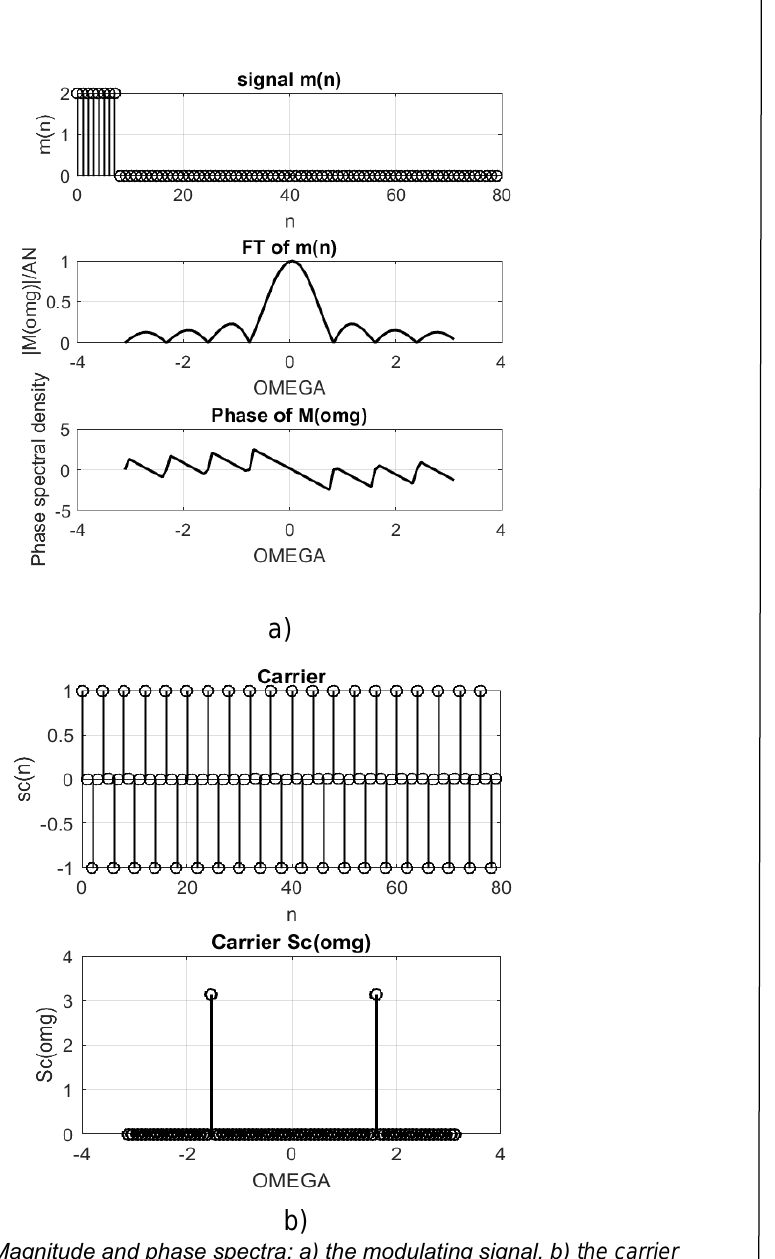
Figure 6 − Magnitude and phase spectra: a) the modulating signal, b) the carrier Рис. 6 – Амплитудный и фазовый спектры: а) модулирующего сигнала,